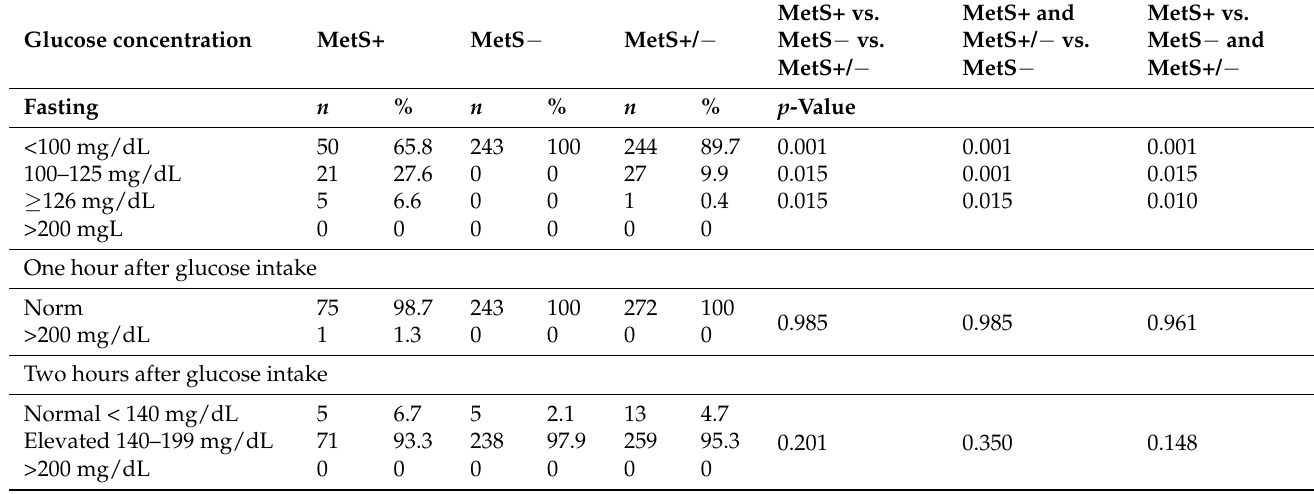
Table 5. Glucose concentration in study population during oral glucose